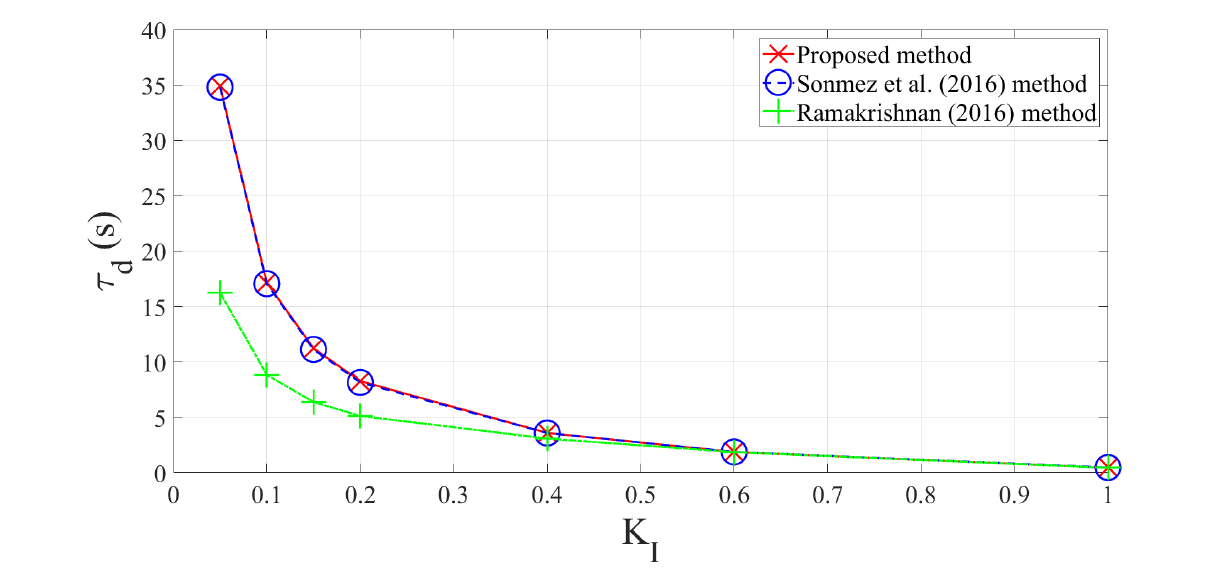
Figure 7. With K P = 0.4, the DM, τ d , is shown against the integral gain, K I , curve [18,28].